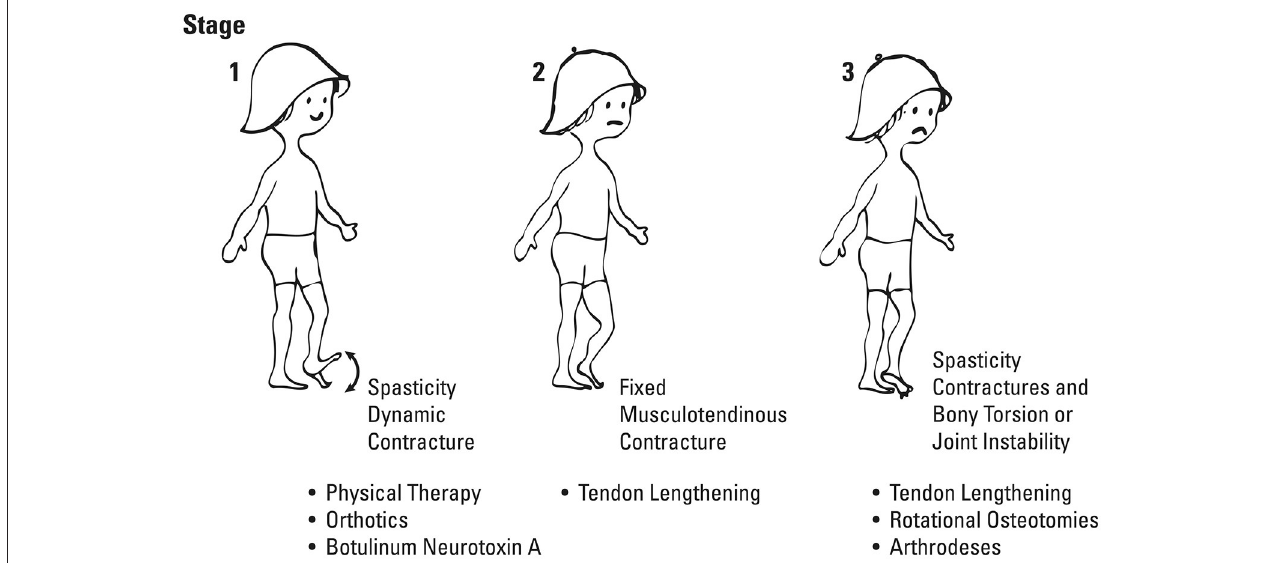
FIGURE 1 | Rang’s three phases of cerebral palsy, the so-called “Traditional View,” which emphasizes spasticity as a primary driver of both muscle and bony deformities. (Used with permission © Bill Reid/Kerr Graham, RCH Melbourne).